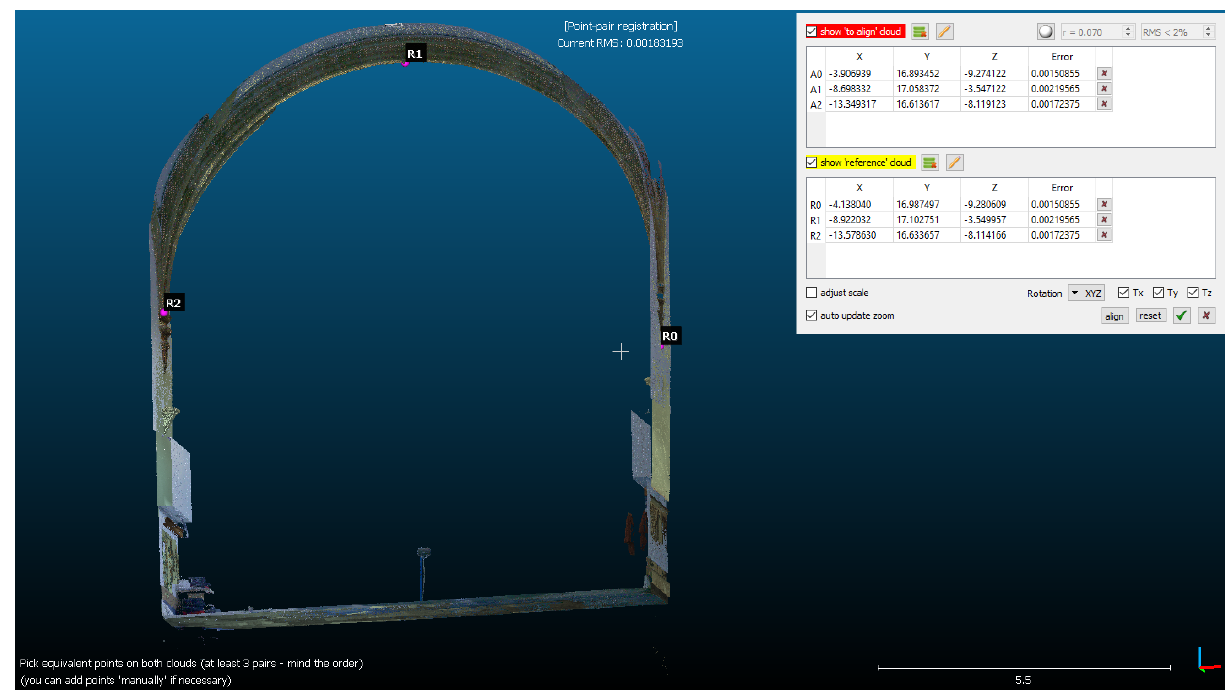
Figure 14. The ordinates are obtained, at least, with 3 fixed reference points ( R 0 , R 1 , R 2 ) in the arches studied with CloudCompare software. Table 4. Comparison of all